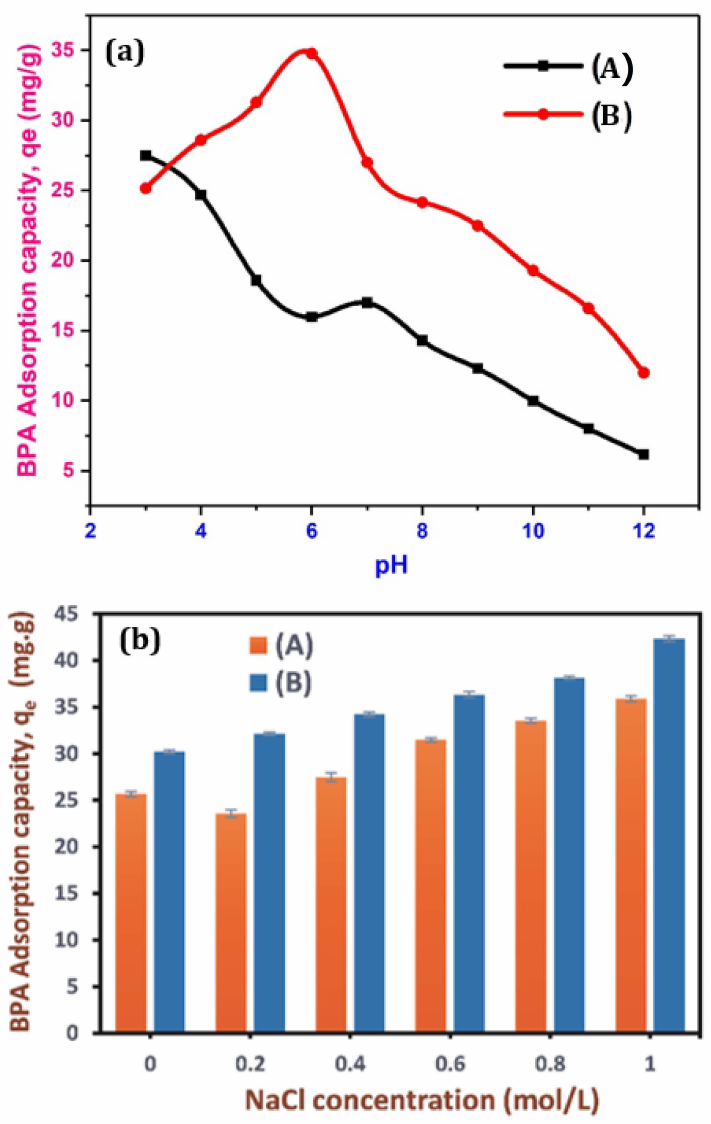
Figure 8. Effect of solution pH ( a ), and ionic strength ( b ) on the adsorption of BPA by NBC and MBC. (BPA concentration: 20 ppm; contact time: 60 min; biochar dose: 0.5 g; and temperature: 293.15